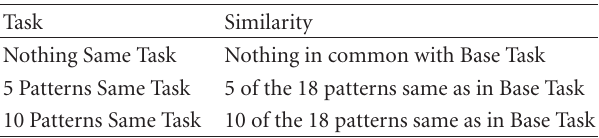
Table 1: Similarities between various tasks as compared to Base